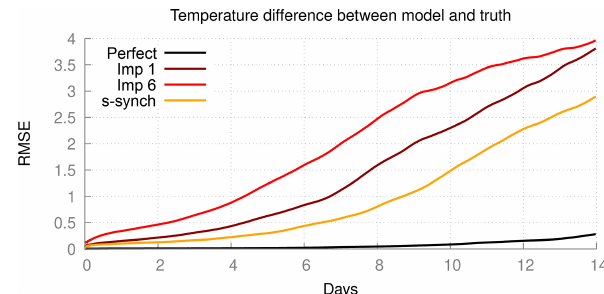
Figure 14. Forecast quality as measured by the RMSE of the truth and a model with a perturbed initial condition. The control is the difference between the perfect model and the perfect model with a perturbed initial condition.